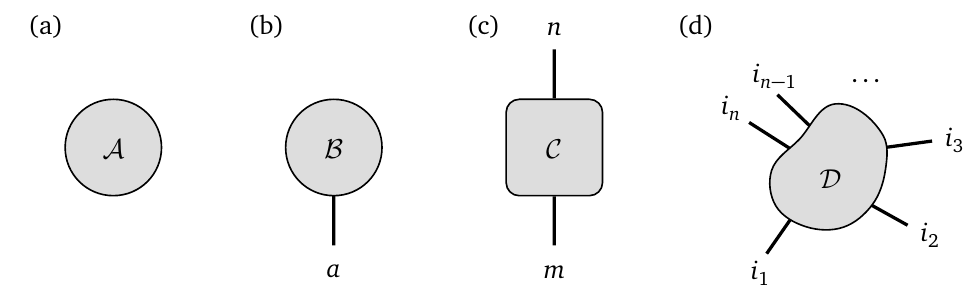
Figure 4: Graphical representation of (a) a zero-link tensor (i.e. a scalar), (b) a one-link tensor (a vector), (c) a two-link tensor (a matrix) and (d) a tensor with an arbitrary number n of links. Indices of a tensor (i.e. its links) can be denoted with arbitrary symbols; the ordering of the open link-ends reflects the order of the indices in the tensor.